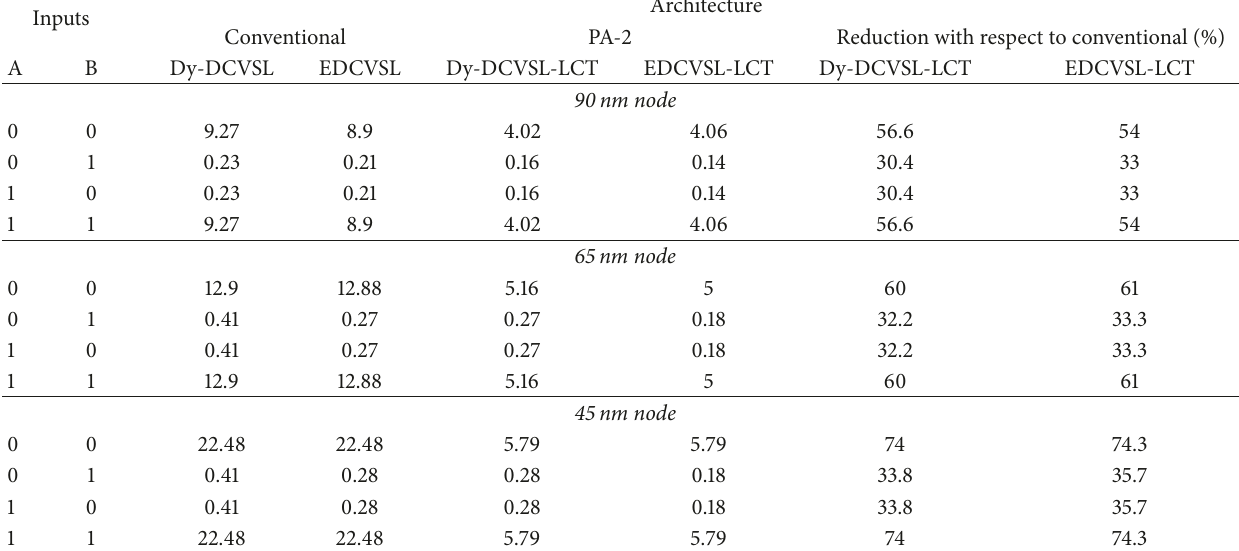
Table 2: Leakage power (nW) for the conventional Dy-DCVSL, EDCVSL-LCT and PA-2 Dy-DCVSL-LCT, EDCVSL-LCT based XOR- XNOR2 gate